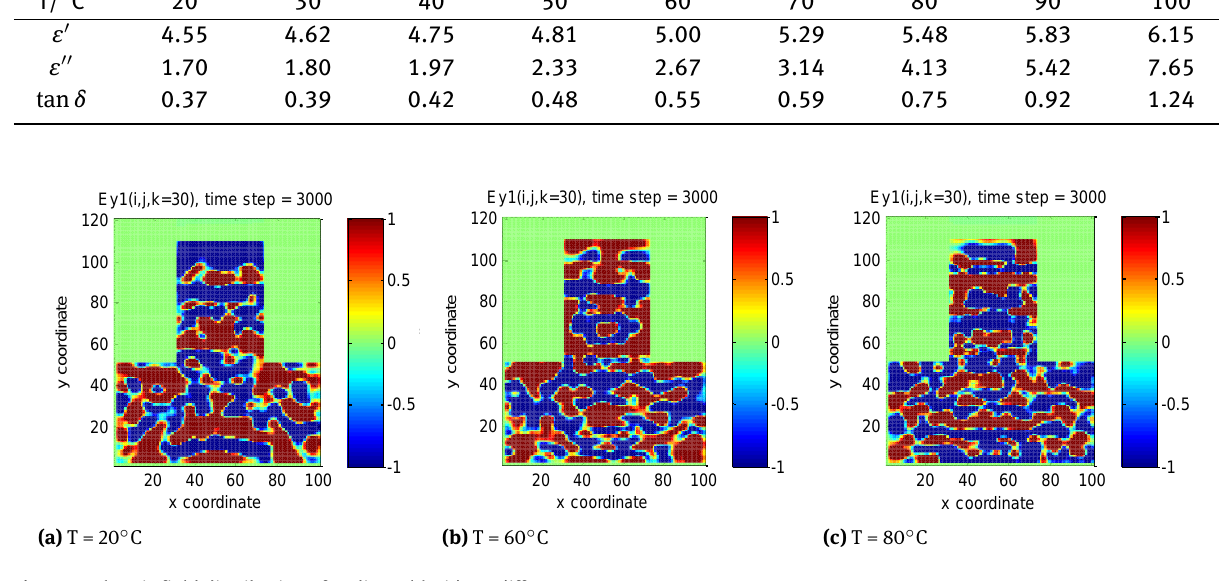
Figure 5: Electric field distribution of sodium chloride at different temperature